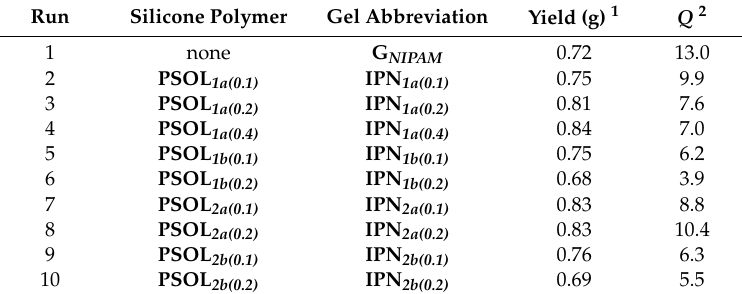
Table 2. IPN synthesis with PSOL 1 and PSOL 2 .